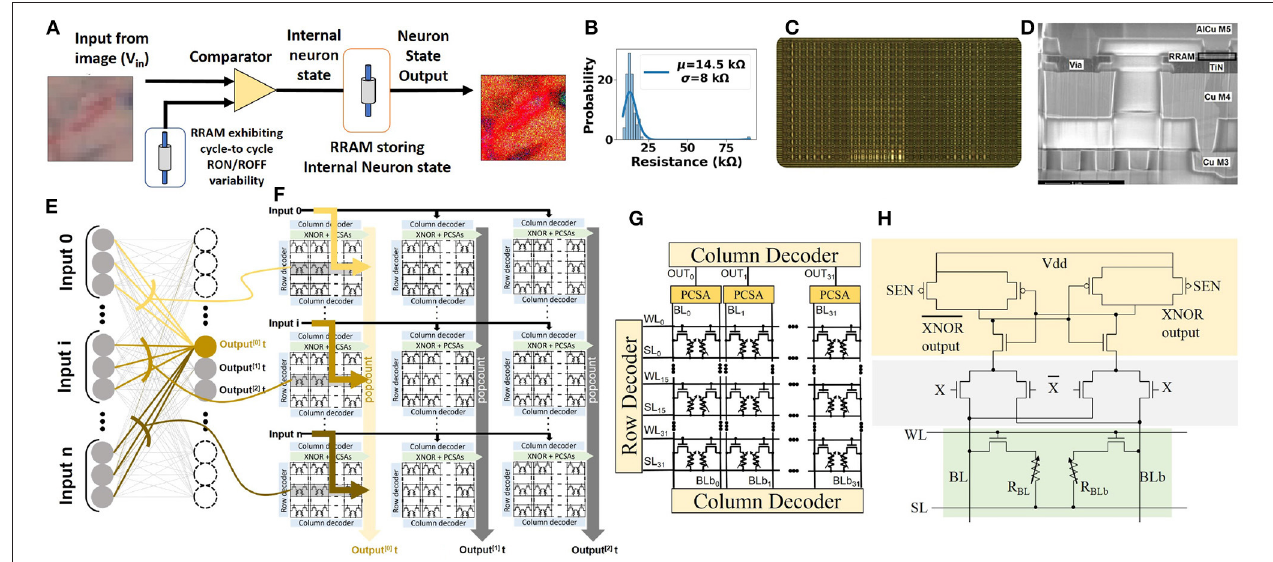
FIGURE 5 | (A) Stochastic neuron circuit based on OxRAM device used for input sampling. 2T-2R in-memory XNOR circuit for BNN computation. (B) C2C variability observed in low resistance state (LRS) for the fabricated OxRAM device of ( Dalgaty et al., 2021). (C) Memory array chip photograph. (D) OxRAM cell. (E) Binarized neural network implementation highlighting connections to one specific neuron. (F) Implementation of binarized neural network in the “parallel to sequential” configuration. (G) 2T-2R bitcell array. (H) Schematic of 2T-2R bit-cell for XNOR operation computation based on pre-charge sense amplifiers (PCSAs) ( Hirtzlin et al., 2019